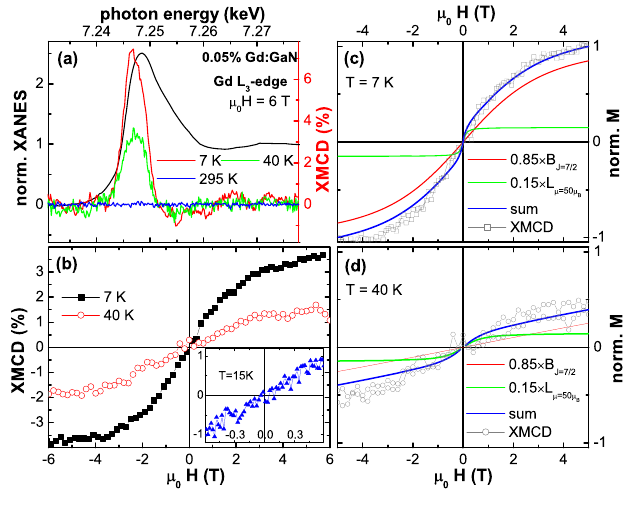
Figure 21. (a) XANES and XMCD recorded at the Gd L Gd:GaN sample at 6 T and various temperatures. (b) M ( H ) -curves recorded at the Gd L -edge at 7 K (black squares) and 40 K (red circles). The inset 3 reveals anhysteretic behavior at 15 K. Modeling of the XMCD M ( H ) -curves (gray symbols) using a superposition of a Brillouin ( B function at (c) 7 K and (d) 40 K (see